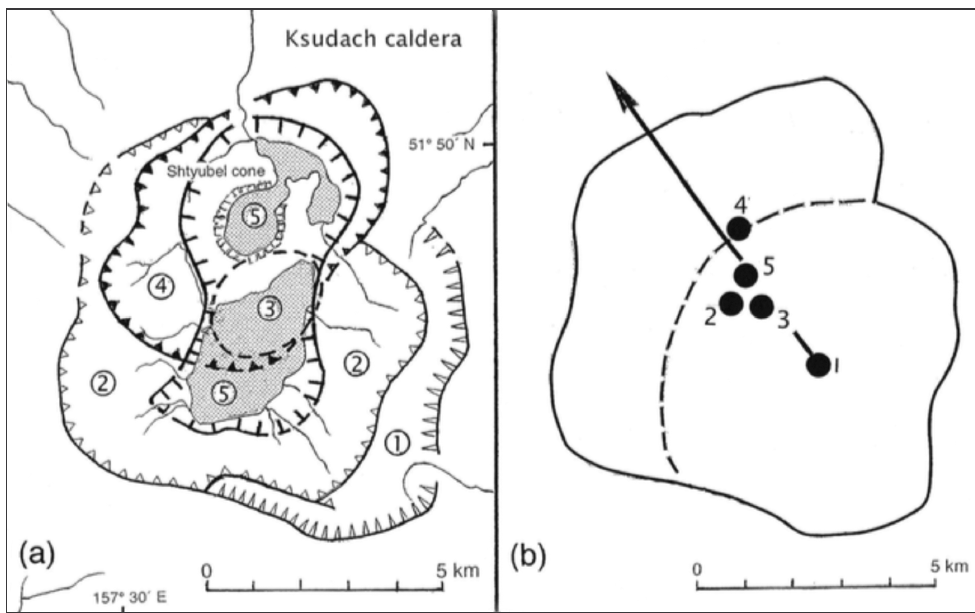
Figure 5. Ksudach caldera, Kamchatka. (a) Caldera areas of the five component calderas after Braitseva et al. [1996]. (b) Migration of the centers of component calderas. The arrow shows a synthesized migratory